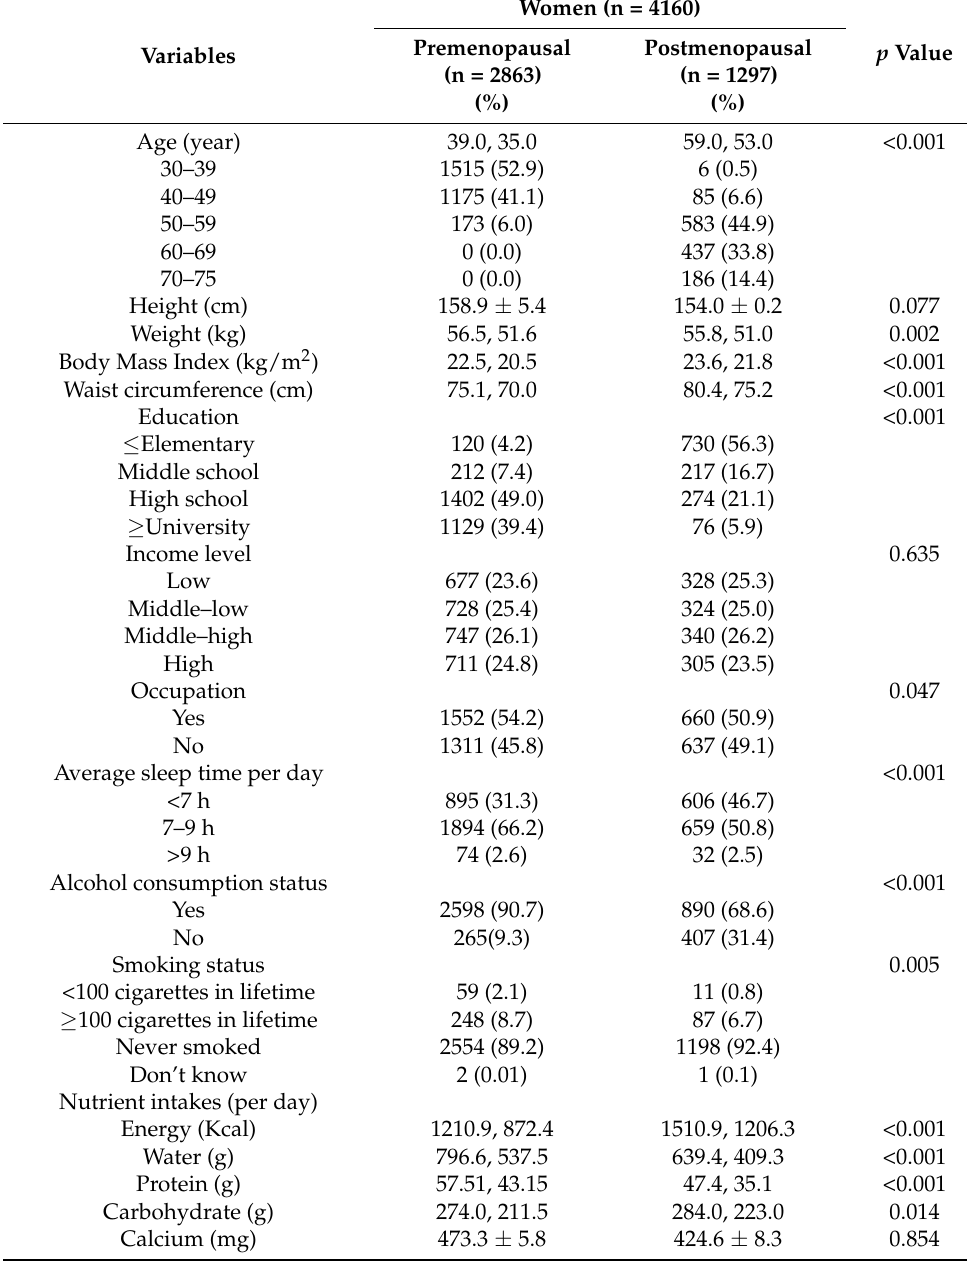
Table 1. Baseline characteristics of the study